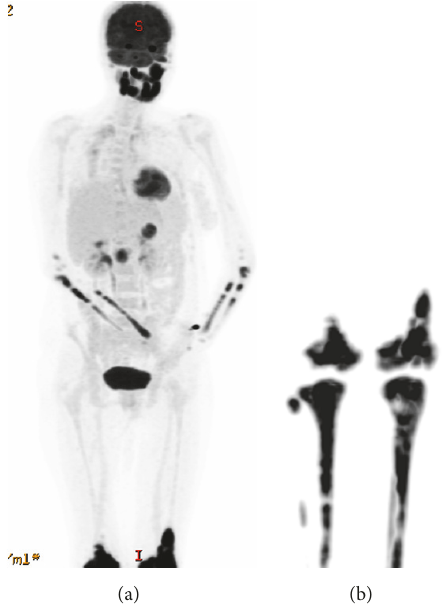
Figure 5: (a) FDG PET scan coronal reformate showing increased FDG uptake in temporal lobes, facial bones, radius, ulna, and distal femora. (b) FDG PET scan coronal reformatted images for the tibia showing bilateral increased FDG uptake in distal femora and tibiae.